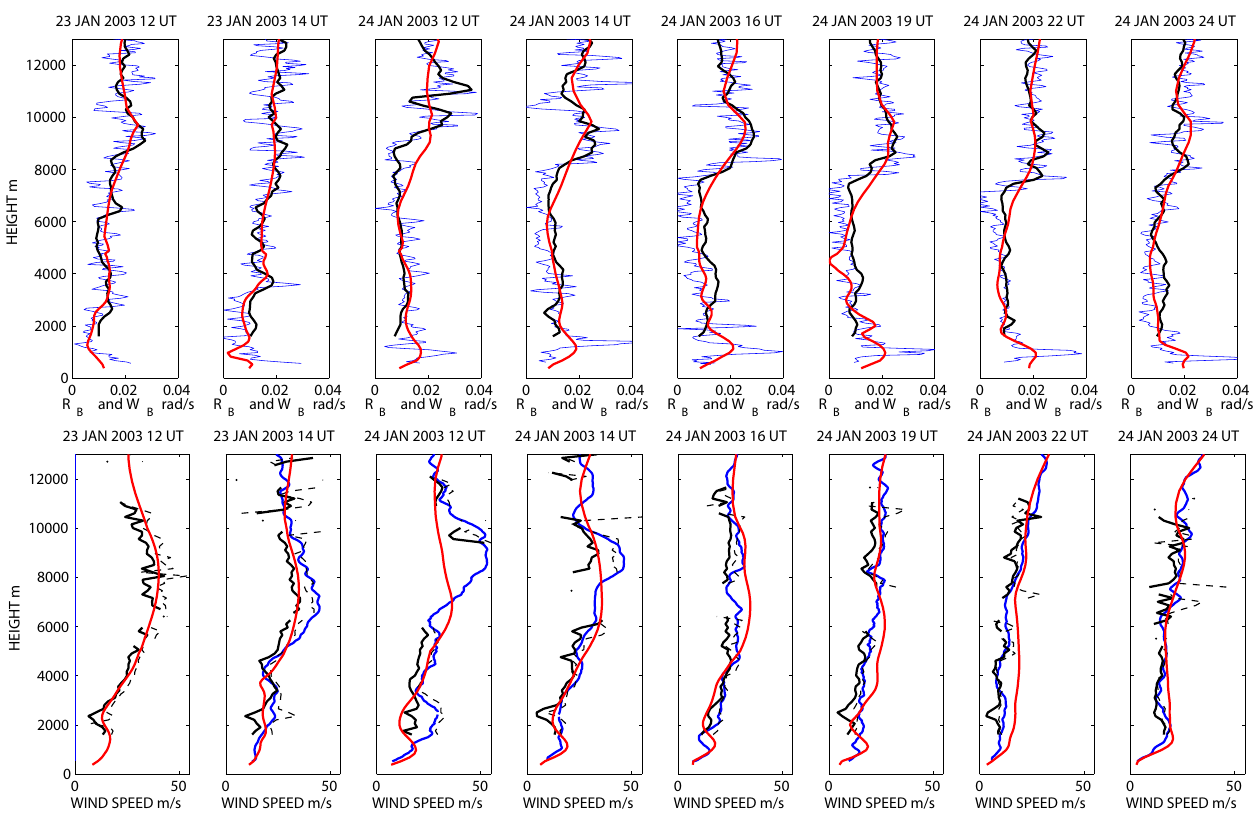
Fig. 4. Radiosonde measurements (blue), ESRAD radar measurements (black) and WRF model results for the ESRAD site (red). All radiosondes were launched from the ESRAD site. ESRAD and WRF results are averaged for 30min following the launch time. Top row shows buoyancy frequency, lower row wind speed. Solid black lines are f.c.a. true winds, dashed lines are apparent winds. See text for further